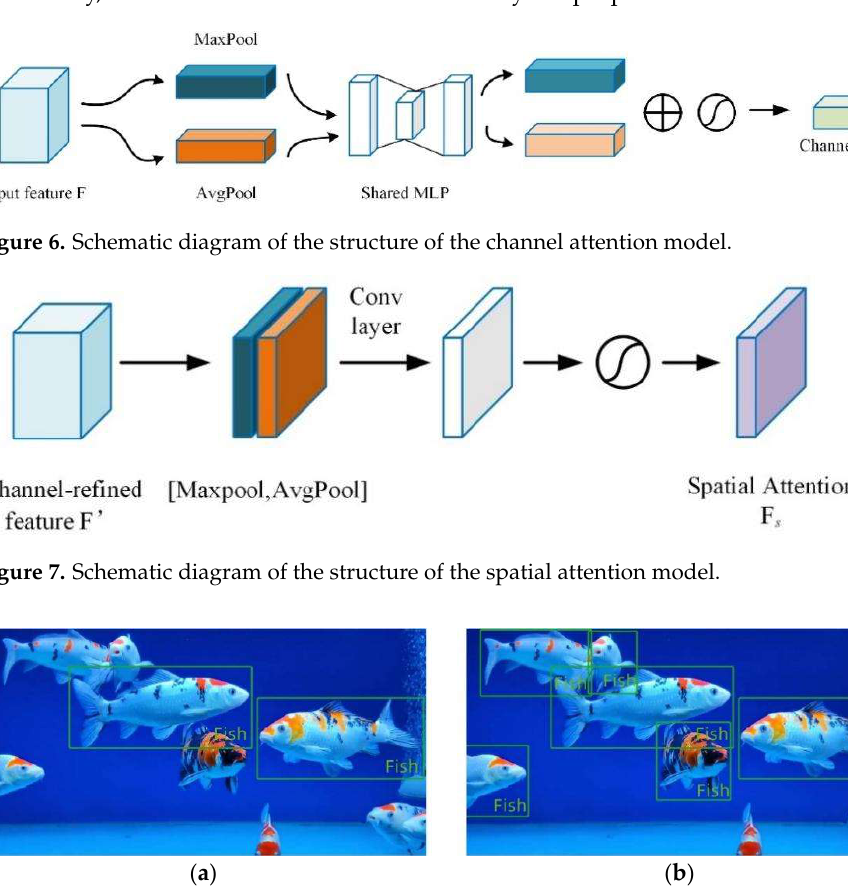
Figure 9. Schematic diagram of the network structure of the individual fish recognition module.